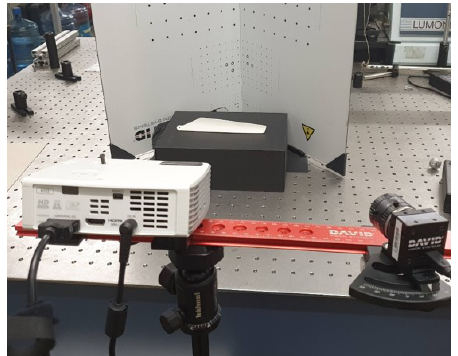
Figure 9. Shape acquisition setup using a DAVID Structured Light 3D Scanner.